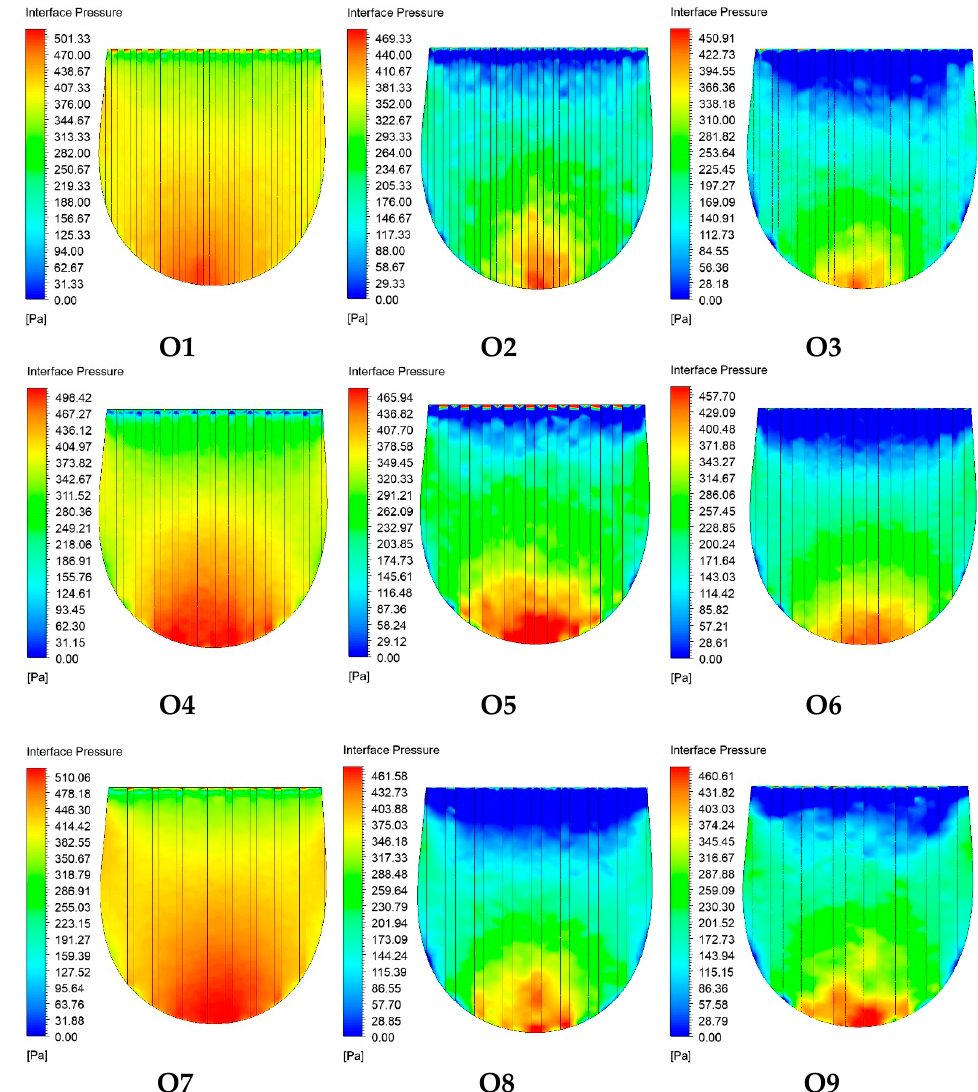
Figure 6. Induced interfacial fluid pressures over the outsoles in the presence of water as a contam- inant .